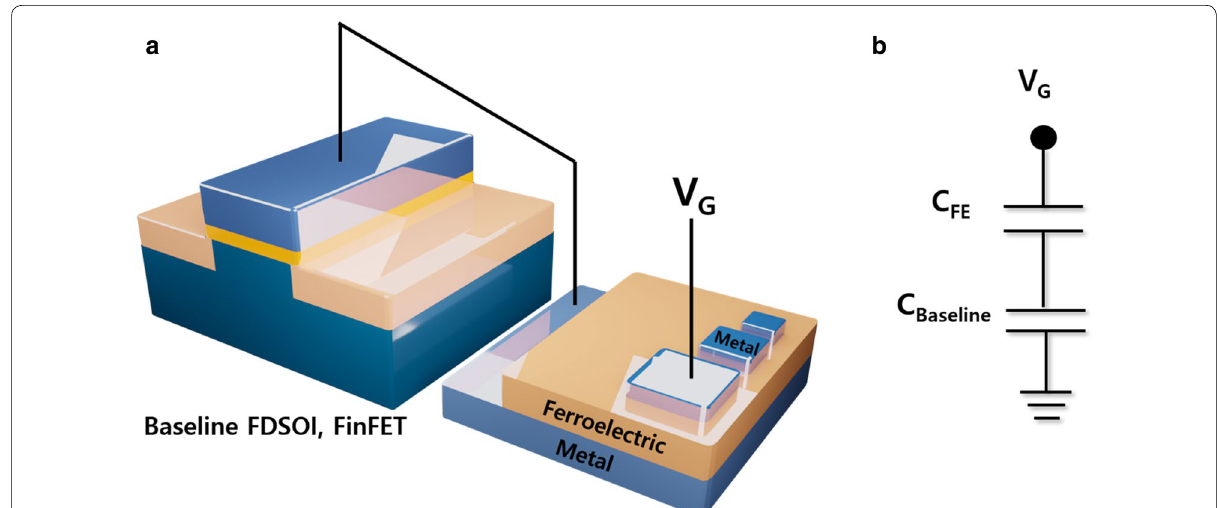
Fig. 2 a Conceptual view showing the ferroelectric capacitor connected in series to the gate electrode of baseline FET. Note that the ferroelectric capacitor is connected in series to FDSOI device or FinFET in this work. b Capacitive circuit schematic of ferroelectric capacitor connected in series to the FDSOI device (FE-FDSOI) or FinFET (FE-FinFET)